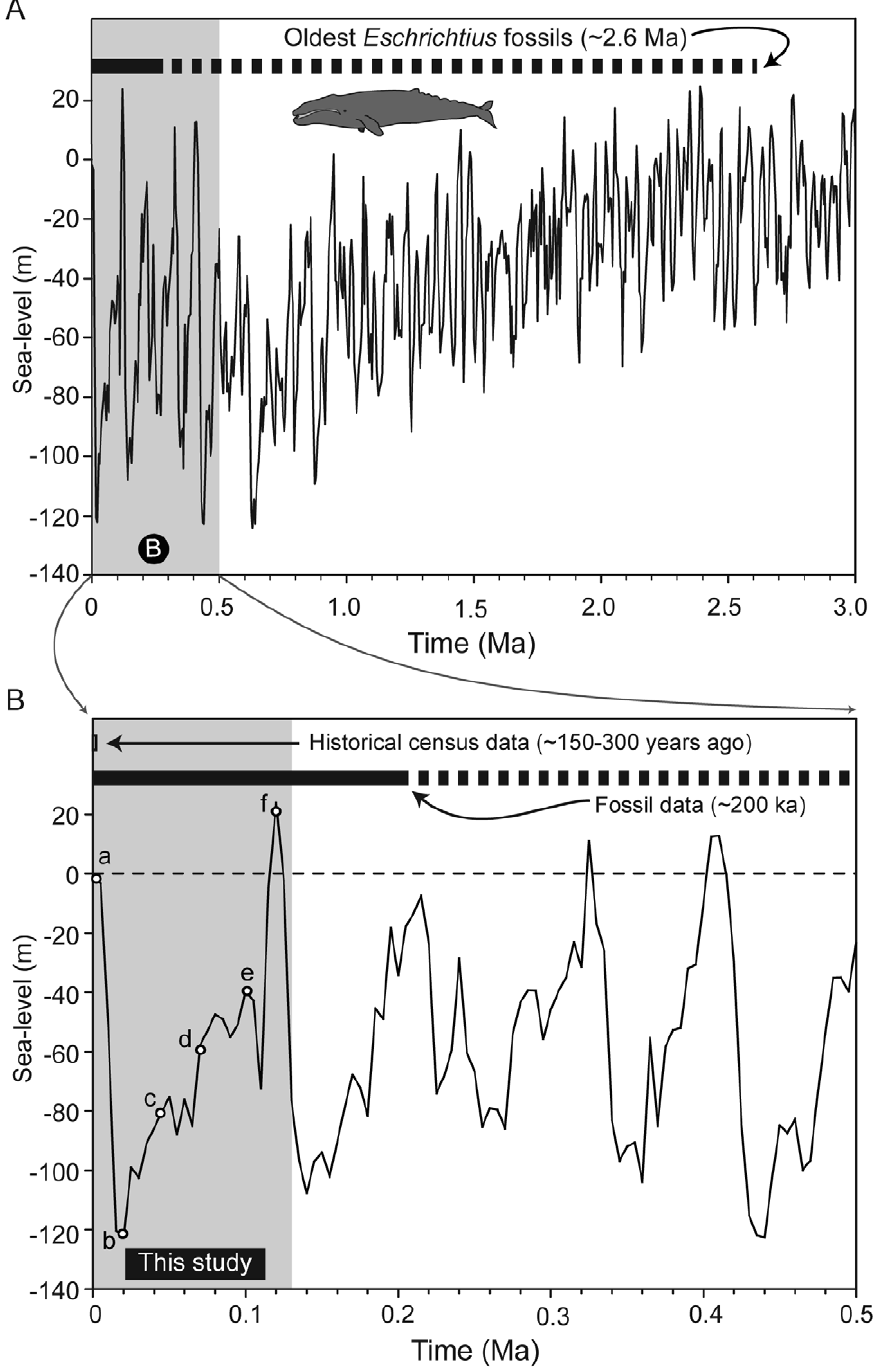
Figure 1. Pliocene through Holocene eustatic sea-level changes, at two different scales. Sea-level change [43] juxtaposed with A) the oldest known fossil belonging to the genus Eschrichtius , from the Pliocene of Japan (dashed line) [98]; and B) the relative temporal ranges from other historical gray whale data, with the oldest example belonging to the species occurrence (solid line), from the Palos Verdes Peninsula of California [101,104]. Age for census estimates reflects an upper bound for reports from the written historical record [28,29,92,93]. doi:10.1371/journal.pone.0021295.g001 the late Pleistocene ( Figure 2 ). Our analyses indicated that the abundance, 85% of the individuals would have been potentially gray whale carrying capacity in the North Pacific Ocean could supported by the northeast and southwest Pacific regions, with have been as high 172,946 individuals (at 120 ka; Figure 3A, 80,831 and 66,154 individuals, respectively (EPN and WPS in Table S2 ), assuming modern day values for benthic productivity, Figure 3A ), while the northwest and southeast regions would have food density, and gray whale energetics. Of this estimated supported only 5,324 and 5,801 individuals, respectively; 15% of